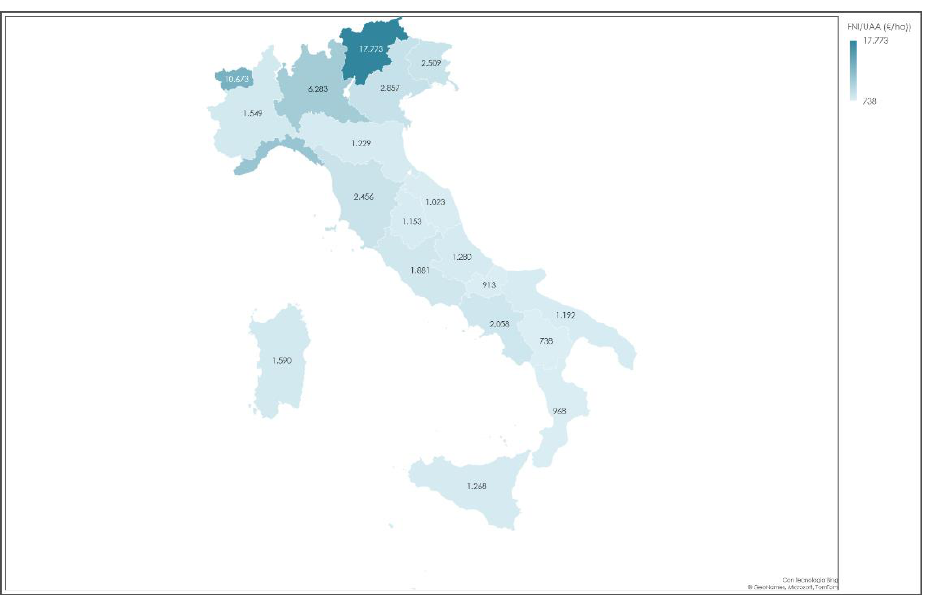
Trentino Alto Adige, located in the north‑east, to about EUR 3000 of